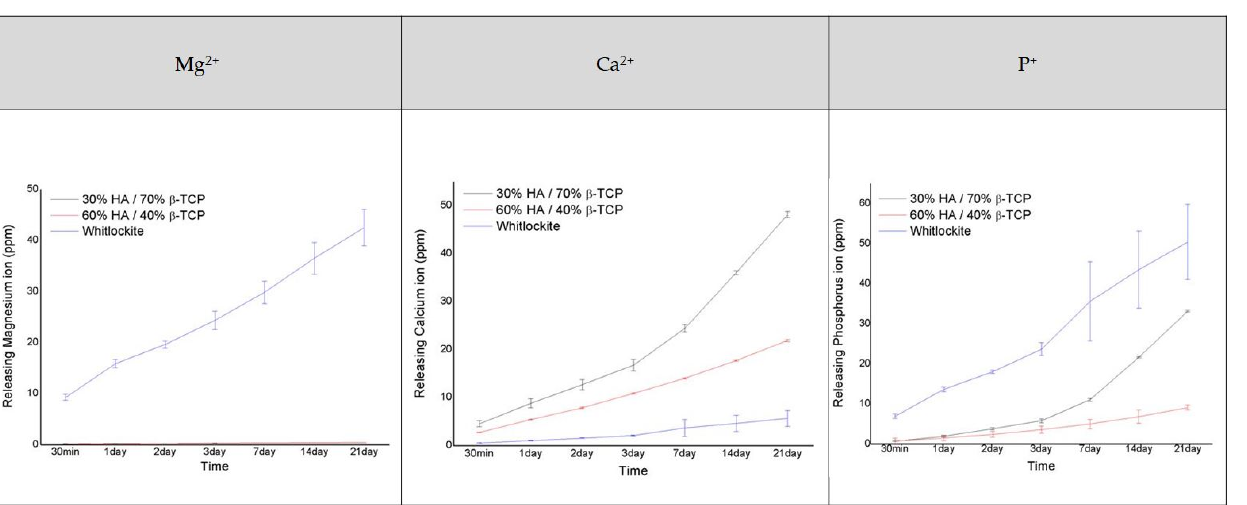
Figure 6. Effect of bone grafts on cell viability of human adipose-derived stem cells. 2.6. Micro-CT Analysis: In Vivo Experiment Six weeks after implantation, the incorporation of the bone graft into the recipient lamina was estimated by micro-computed tomography (CT) (Figure 7). The MagOss group showed a larger fusion mass and better graft incorporation into the lamina than other groups. Groups A, B, C, and D showed lower fusion mass and little incorporation into the recipient lamina. The MagOss group demonstrated enhanced bone regeneration